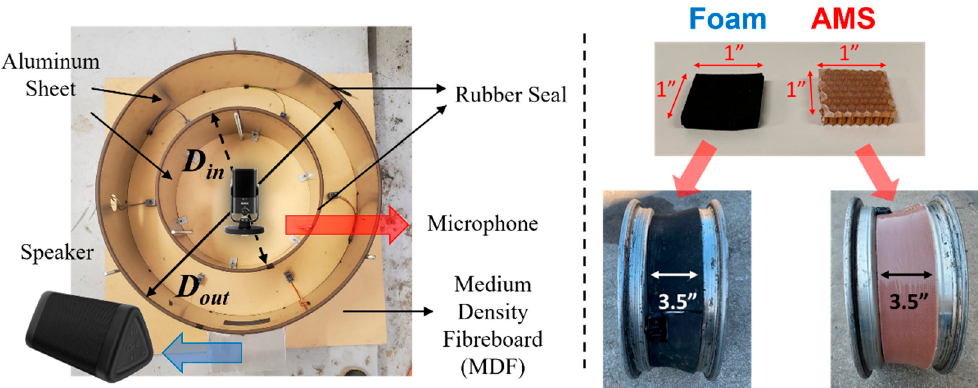
Figure 3. ( Left ) Tire cavity model representing a tire, 235/65R18. At the bottom, there is a hole for the speaker which generates white noise to represent TPIN. The Rode NT-USB mini microphone was mounted in the center of the inner cavity and connected to the computer with the USB cable. ( Right ) The rim of the tire (Pirelli Tire), 185/65R15, of Toyota Prius hybrid 2008. The foam and the AMS were bonded on the circumference of the rim, 3.5 ″ width.